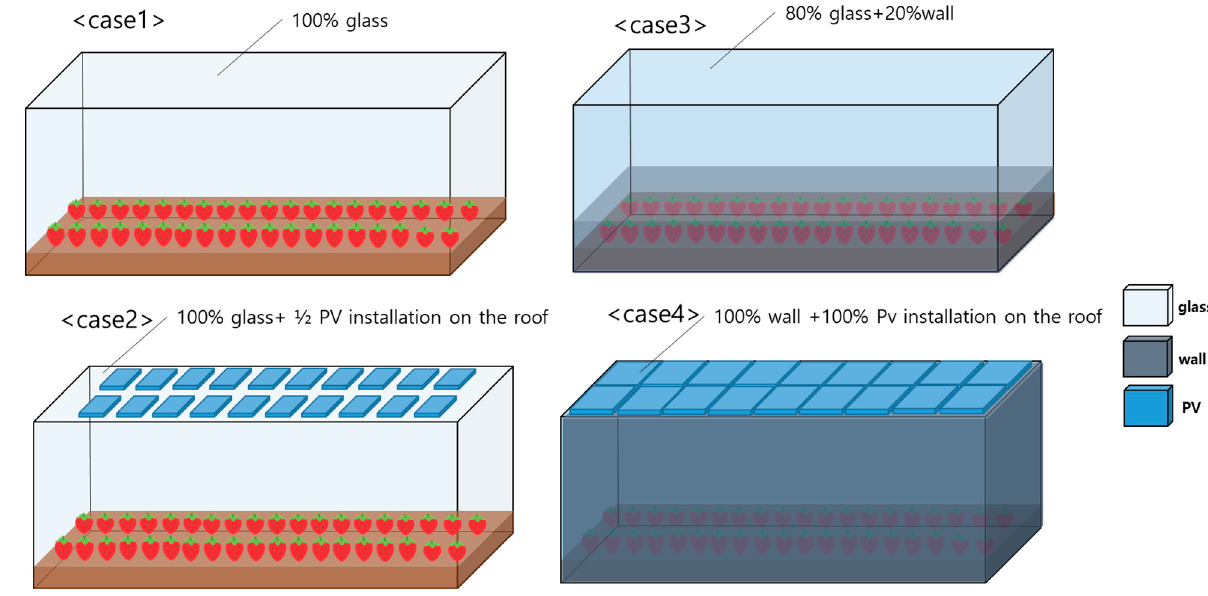
Figure 1. Case geometry for simulation ( a ) Case 1, ( b ) Cases 2–4.